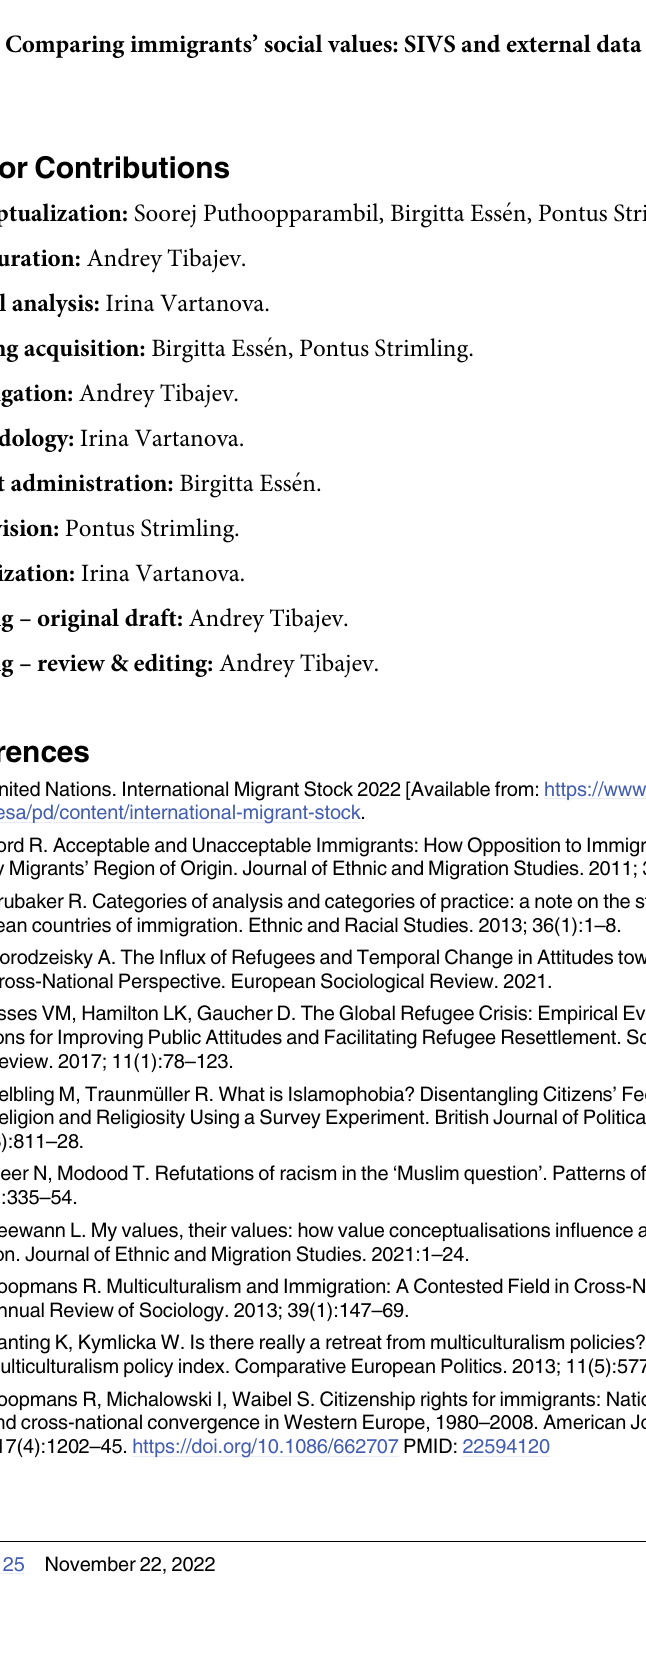
S3 Table. Full results for the multi-level regressions. (PDF) S1 Fig. Liberal advantage of issue positions. (TIFF) S2 Fig. Comparing immigrants’ social values: SIVS and external data